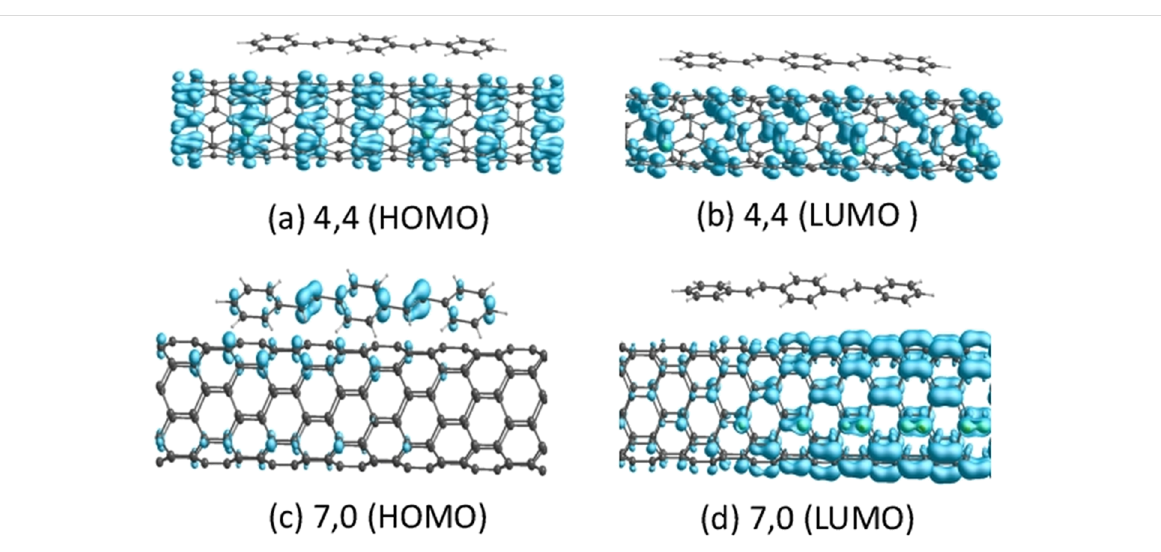
ages x of SWNTs in the matrix. As a consequence, although the PL signal becomes weaker as x increases, there is a blue shift of the overall remaining emission. A comparable behavior has been observed at the interface of PPV/MWCNT bilayers